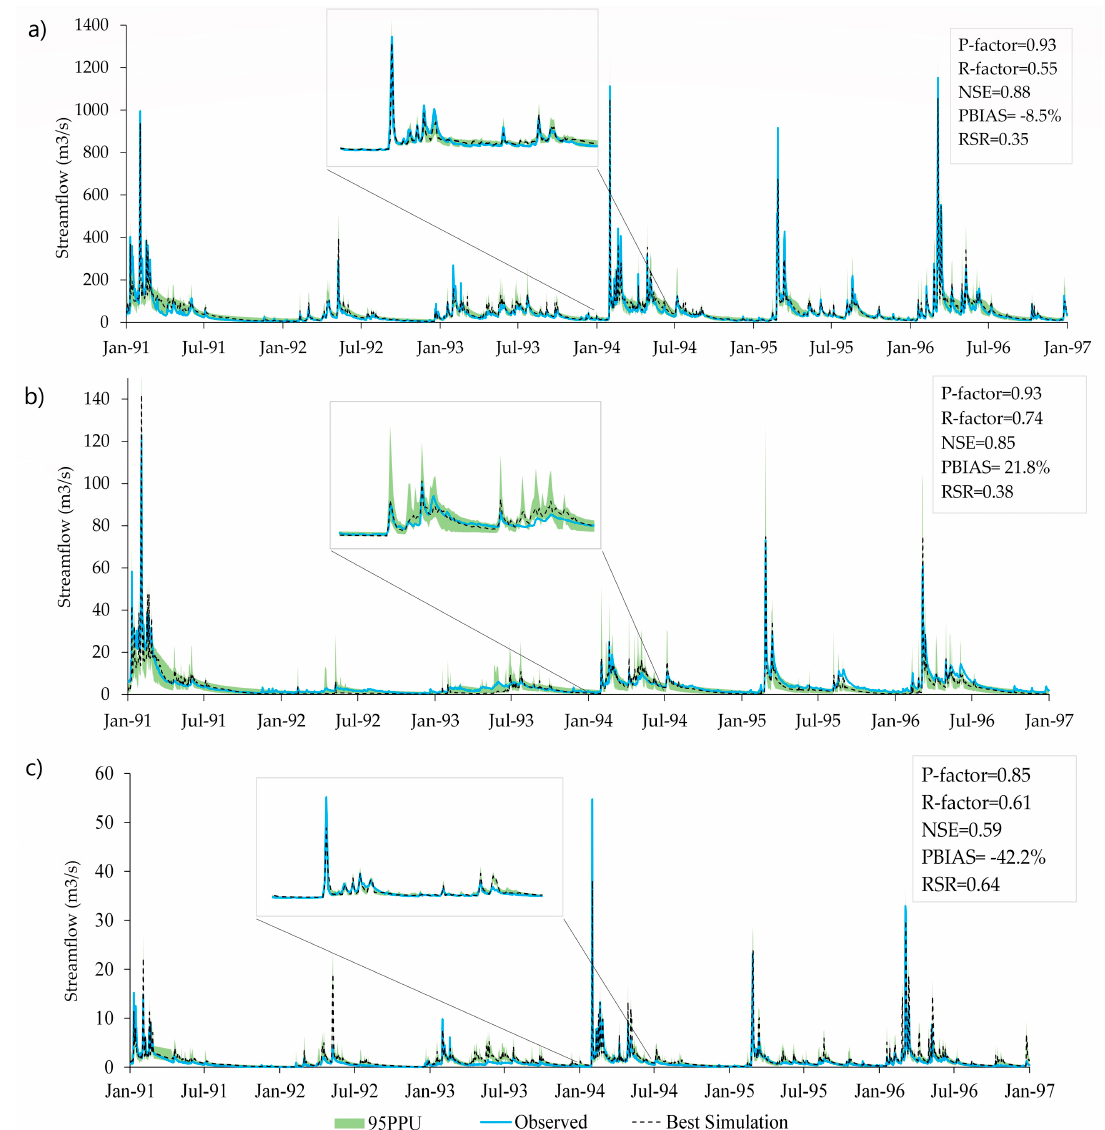
Figure 3. Streamflow calibration and uncertainty analysis: ( a ) Tung Oil station near the outlet of the catchment, ( b ) Glenn Allyn station in the upper section, and ( c ) Fisher Creek station.